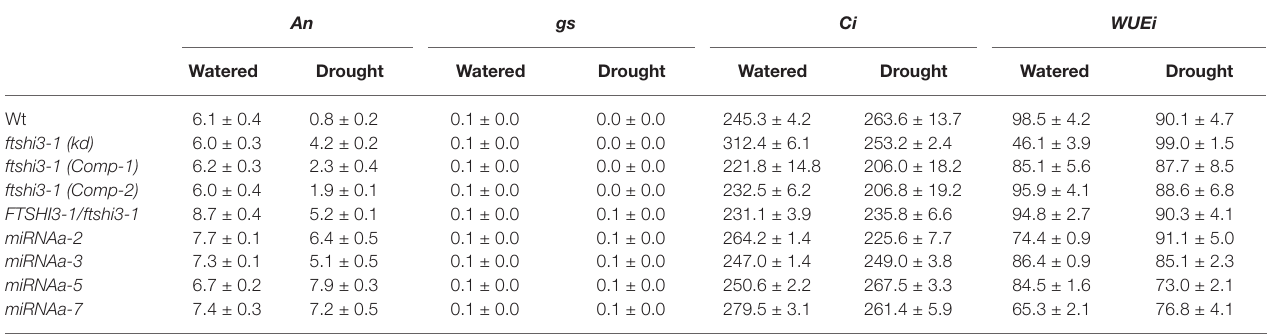
TABLE 1 | Gas-exchange analyses performed on Wt, ftshi3-1(kd) , ftshi3-1 ( Comp-1 and Comp-2 ), miRNA-a2/a3/a5/a7 , and Ftshi3-1 / ftshi3-1 lines grown in watered and drought conditions. An gs Ci WUEi Watered Drought Watered Drought Watered Drought Watered